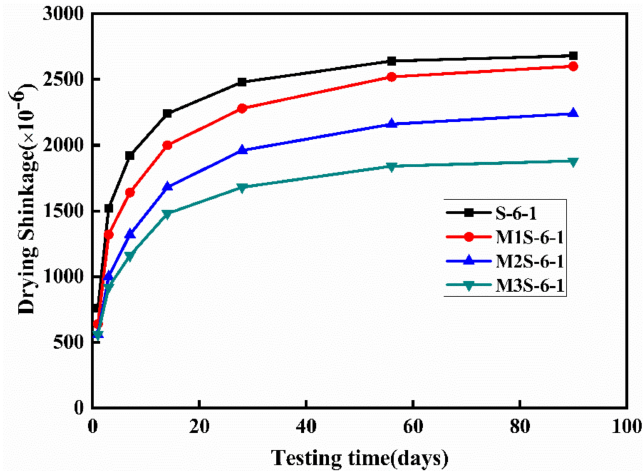
Figure 10. Effect of metakaolin content on the drying shrinkage of alkali-activated slag